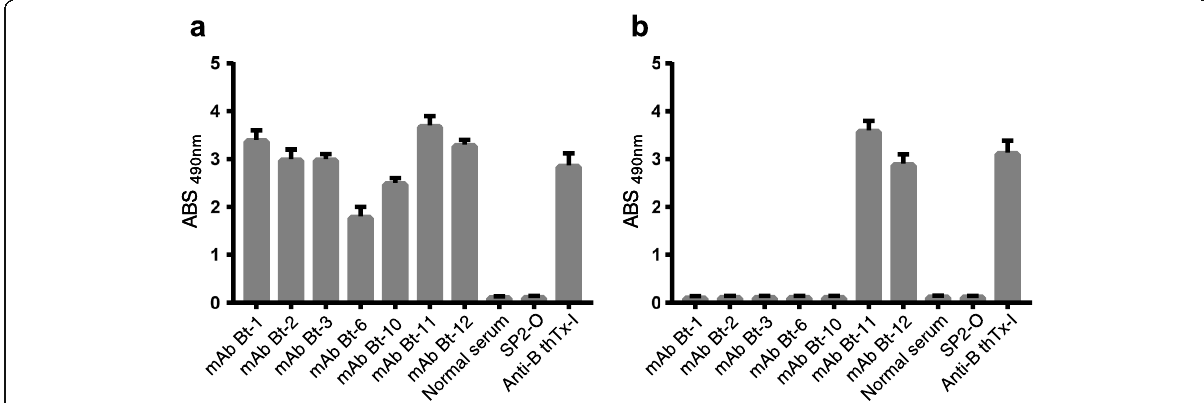
Fig. 2 Analysis of mAb recognition of Bothrops venoms. ELISA plates were sensitized with crude venom of ( a ) B. jararacussu or ( b ) southeastern B. jararaca , and then tested with mAbs. The test was performed in triplicate and serum polyclonal anti-BthTx-I produced in mice was used as positive control. Normal serum and supernatant of SP2-O cells provided negative